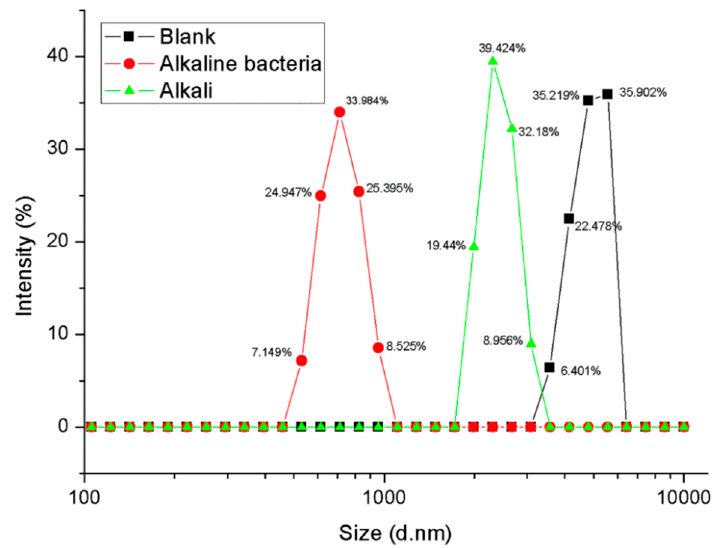
Figure 5. Changes in particle size of PET particles treated by alkali-resistant strain and alkali (Intensity %: the percentage of particles of different particle sizes to total particles).